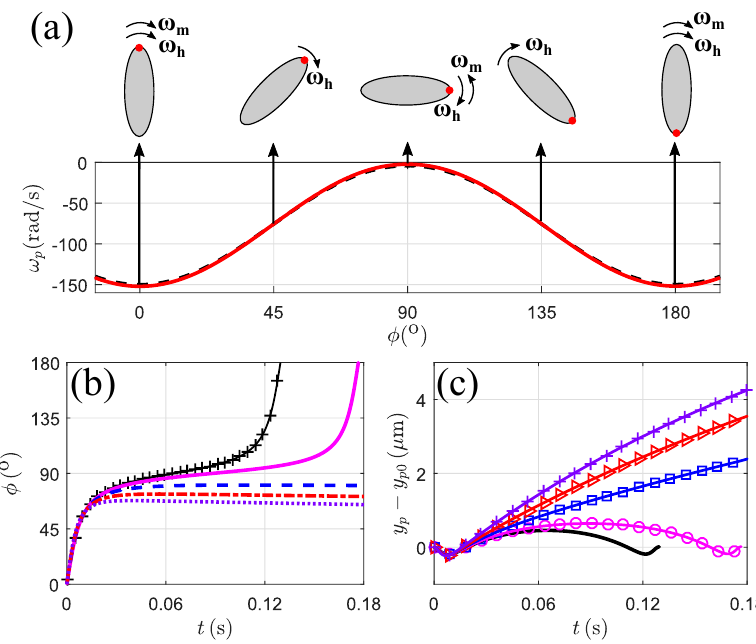
Figure 11. Effect of the magnetic field when it is applied at α = 45 ◦ . The particle ( AR = 4) is initially located at y p 0 = 12 µ m. ( a ) the total rotational velocity ω p versus φ for H 0 = 0(dash) and 3000 A/m (solid); ( b ) φ versus time t over a period for H 0 = 0 (plus), 1000 A/m (solid), 2000 A/m (dash), 3000 A/m (dash-dot) and 4000 A/m (dot); ( c ) the migration of particle y p − y p 0 as a function of t for H 0 = 0 (solid), 1000 A/m (circle), 2000 A/m (rectangle), 3000 A/m (triangle) and 4000 A/m